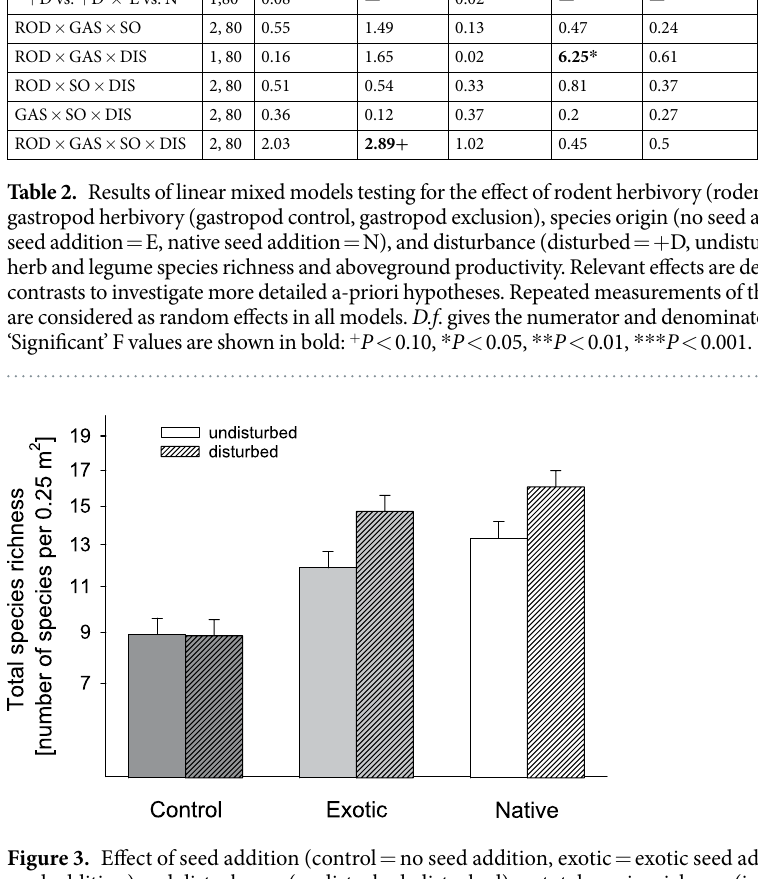
or cover crops 43 . We may therefore assume a human pre-selection of these species for high productivity and faster growth 44 , being associated with lower levels of resistance but probably higher levels of tolerance 45 . Lower herbi- vore resistance would be in line with the preference of gastropods for these exotics. Another important finding of our study was that gastropods reduced seedling recruitment of exotic legumes particularly at disturbed plots, which also explains the negative response of exotic legumes to disturbance (see above). Thus, gastropods can even diminish invasion opportunities provided by disturbances of the vegetation cover 30,31 . A possible mech- anism underlying this result may be that disturbance increased the apparency of palatable exotic species for gastropods 46 .